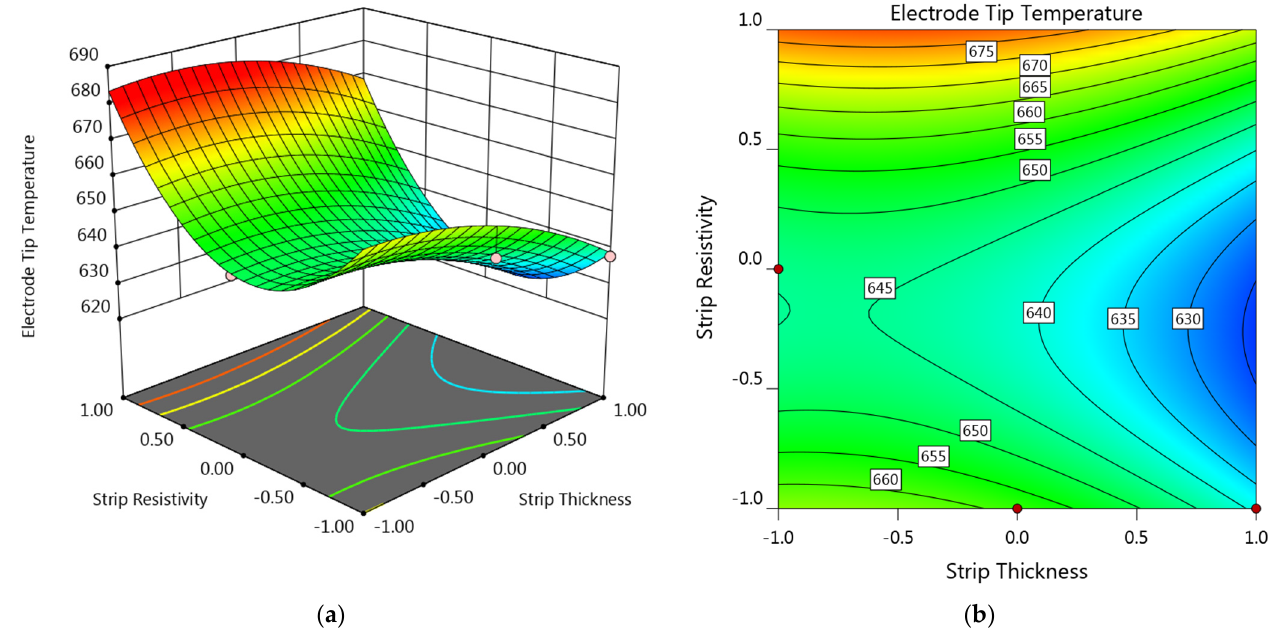
Figure 9. ( a ) Response surface and ( b ) contour plot showing the effect of factor A and C on the electrode tip temperature at B = 0 and D = − 1.